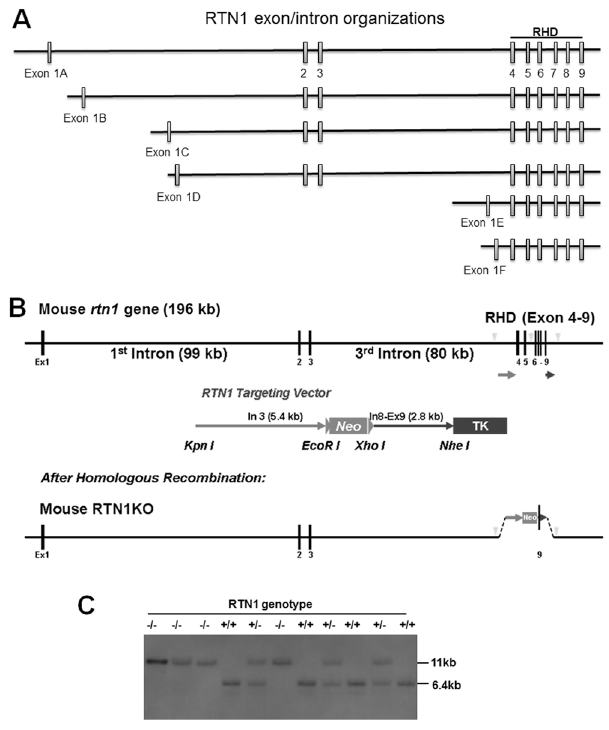
Figure 1. Generation of RTN1-null mice. ( A ) Schematic illustration of genomic structures of the mouse rtn1 gene, with each box representing an exon. The exon size is not proportionally represented. Exon 1A to 1F contains the translation initiation codon. The reticulon homology domain (RHD) is encoded by exons 4 to 9. ( B ) Targeting DNA vector (the standard Neo/TK cassette) is generated by insertion of two arms: one 5.4 kb fragment from intron 3, and the other 2.8 kd fragment having a sequence spanning intron 8 to exon 9. The restriction enzymes used for generation these two fragments are illustrated. The arrowhead indicates the Eco RI site. ( C ) Southern blotting was performed to validate the founder lines of RTN1 knockout (KO) mice and subsequently generated RTN1-null mice. KO mice produce an 11 kb DNA fragment, while wild-type (WT) mice produce a 6.4Kb DNA